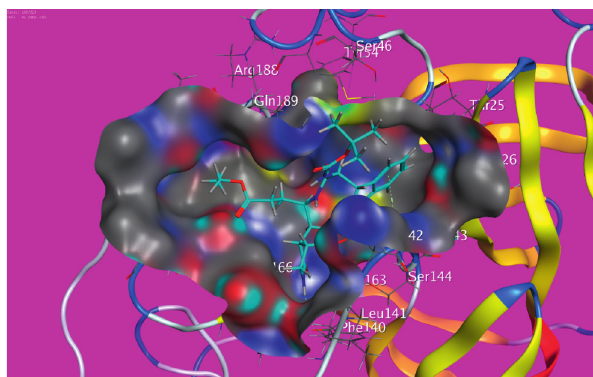
Figure 3: Mapping surface showing the cocrystallized ligand (PRD-002214) occupying the active pocket of the COVID-19 main protease.